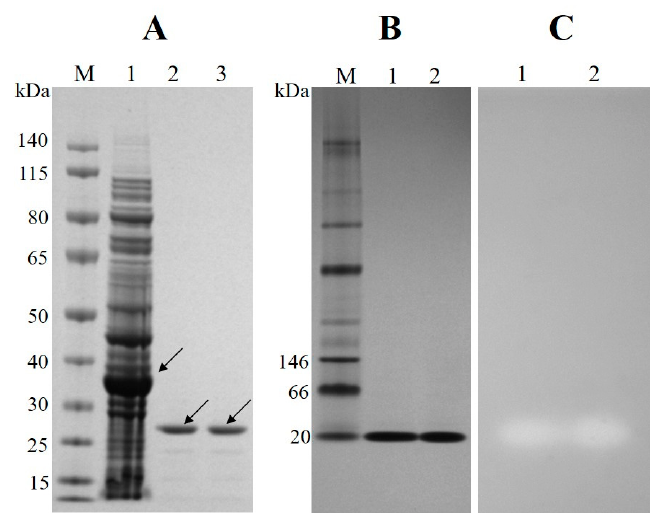
Figure 2. ( A ) SDS-PAGE analysis of overexpressed and Profinity eXact purified Est6 in E. coli BL21 Star (DE3). Samples were run on a 4–12% NuPAGE Novex Bis-Tris mini gel. Lane M, protein molecular mass ladder (Fermentas); lane 1, total soluble cell protein; lane 2, Est6 in 50 mM sodium phosphate buffer (pH 7.0); lane 3, Est6 in 50 mM Tris-HCl buffer (pH 8.0). The arrows indicate the Profinity eXact tagged Est6 and tag-free Est6, respectively. ( B ) Native PAGE analysis of purified